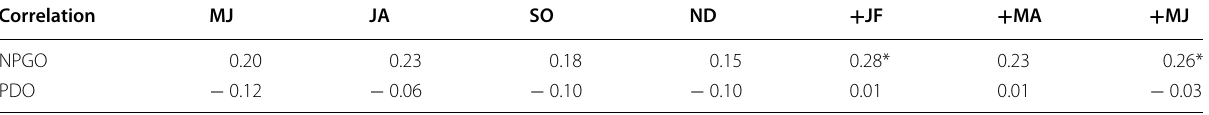
* 0.05 significant